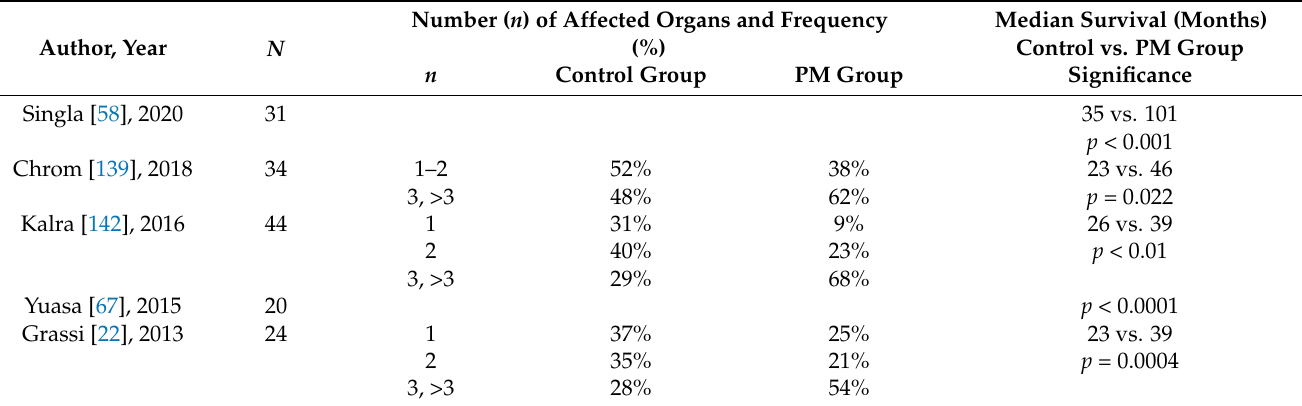
Table 3. Site metastatic RCC with and without PM and survival; ( N = size of the PM group; n = number of metastatic organ sites in the PM group and in control (non-PM)